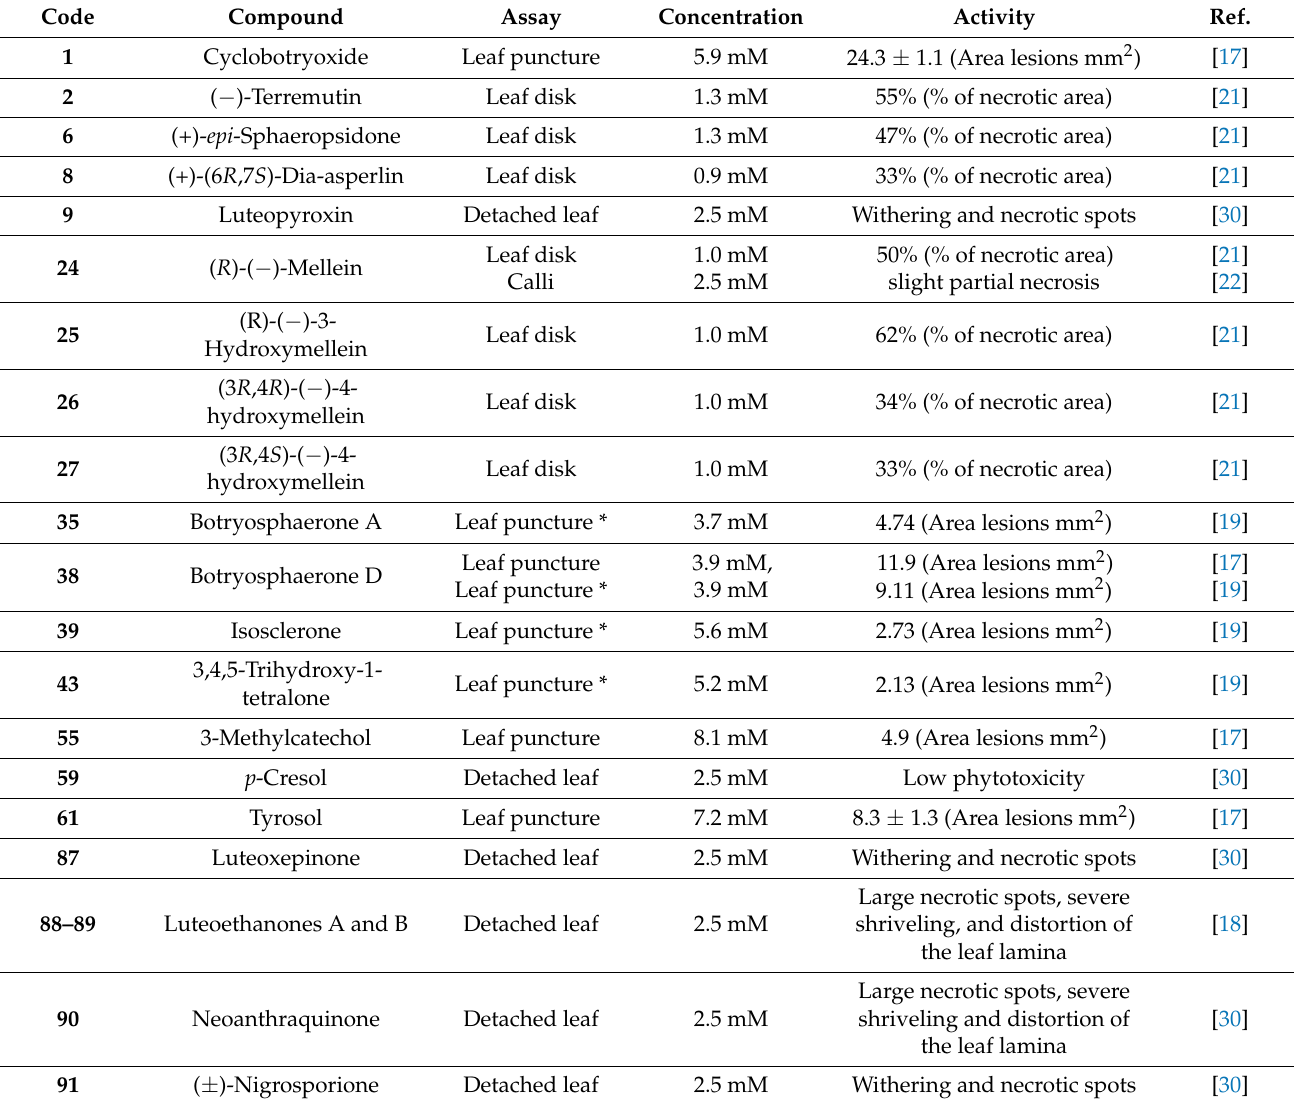
Table 3. Phytotoxicity of metabolites produced by Neofusicoccum species on